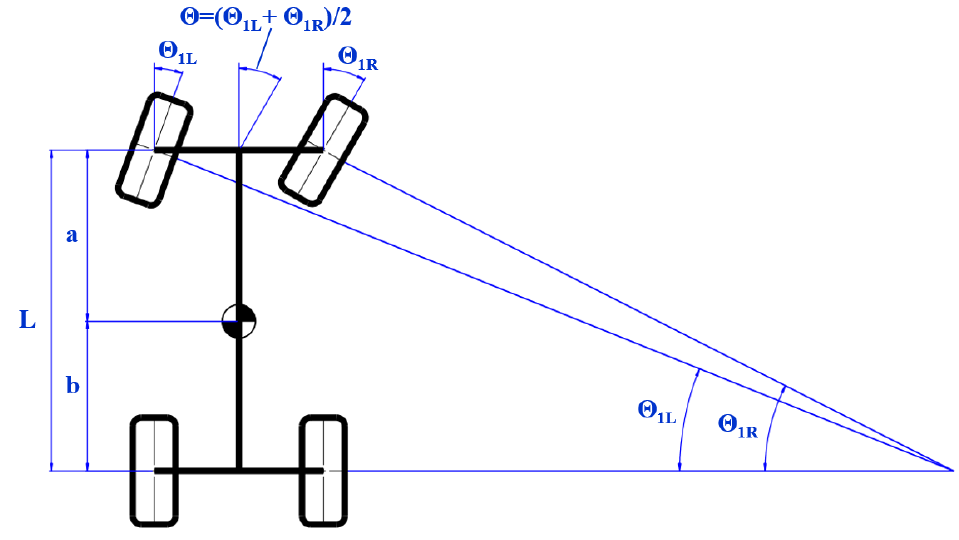
Figure 1. Ackermann — Jeantaud schema [47]. Figure 1. Ackermann—Jeantaud schema